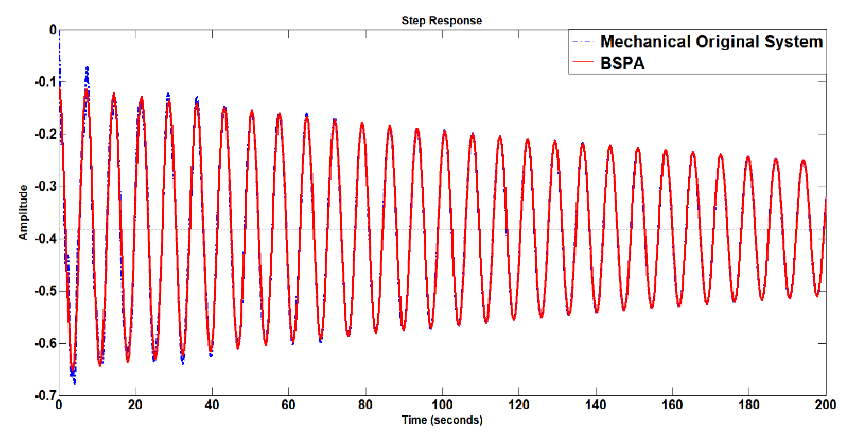
Figure 9. Time response of ROM with OS for 200s (time)